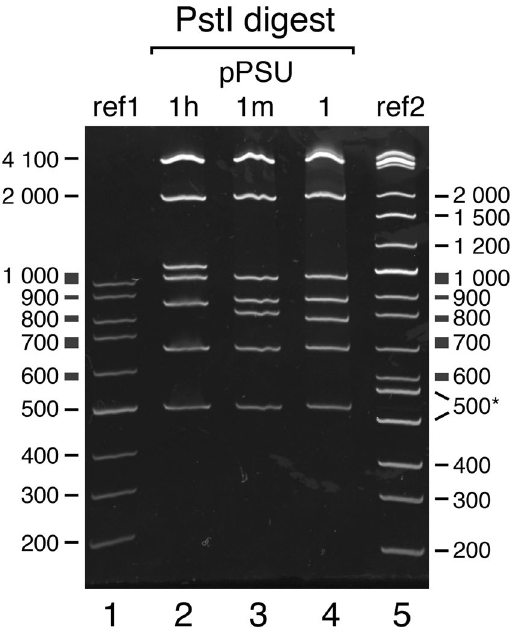
Figure 3. Optimization of 100 bp ladder fragments for polyacrylamide gel electrophoresis (10% acrylamide gel). Lane 1: reference Thermo Scientific Gene Ruler 100 bp ladder (ref1). Lane 2: PstI digestion of the intermediate pPSU1h plasmid contains 800, 900, and 1000 bp lambda DNA fragments which migrate anomalously slowly. Lane 3: pPSU1m contains replacements for the 800, 900 bp fragments from lambda DNA and the 1000 bp fragment from the human Bmi1 RING domain gene. The replacement 800 bp PstI fragment still migrates anomalously slowly. Lane 4: PstI digestion of the final pPSU1 plasmid containing a replacement 800 bp fragment from the human G9a histone methyltransferase gene. Lane 5: reference New England Biolabs 2-Log DNA ladder (ref2). The reference Thermo Scientific Gene Ruler 700 and 1000 bp fragments appear to migrate anomalously, as do the NEB 2-Log DNA ladder 500, 517, 800 and 1000 bp fragments on this 10% acrylamide